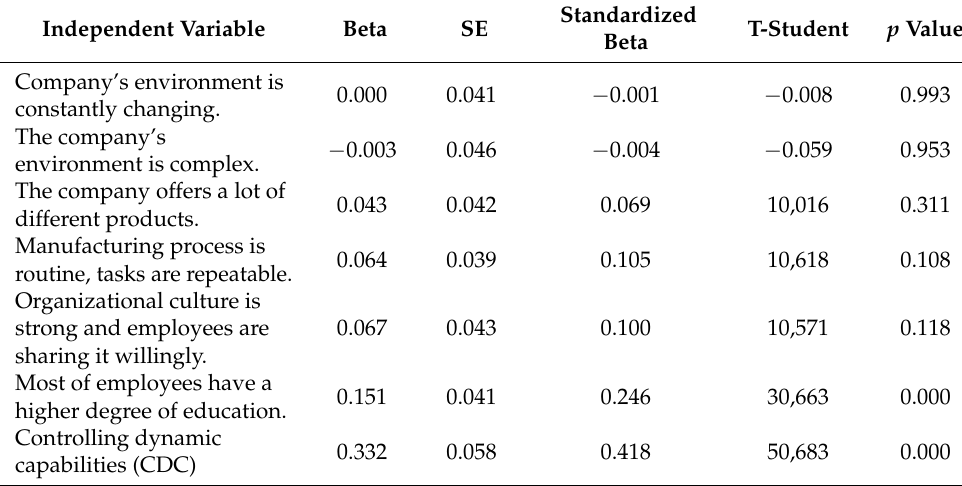
Table 3. Regression analysis with control variables.